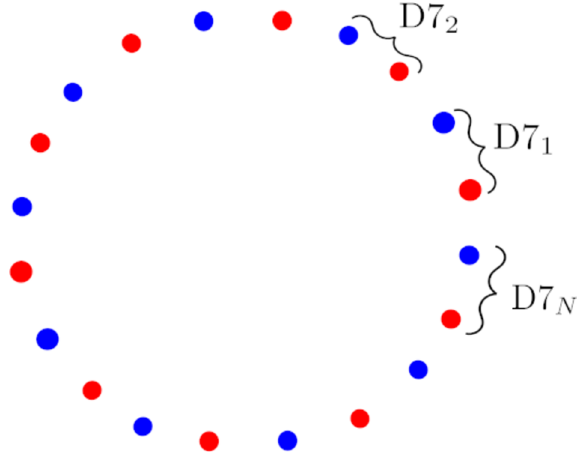
Figure 4 . The 2 N monodromy defects forming N perturbative D7 branes, depicted on the trans- verse plane, at the origin of the Coulomb branch. Locally, each defect looks the same, but the ones drawn in blue are mutually non-local compared to the ones drawn in red.